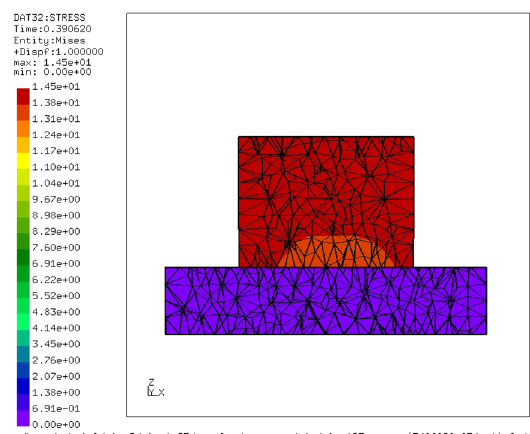
Figure 7 are the Stress vs. Strain curves experimentally calculated with a strain rate of 1 s -1 (gray dotted lines) and the Von Mises stress vs. Von Mises Equivalent Strain curves in the middle of the sample obtained from the simulation (green and red lines). The experimental stress was calculated taking into account the Dieter friction correction 19 and the Torrente 20 friction correction, equations 12 and 13, respectively.